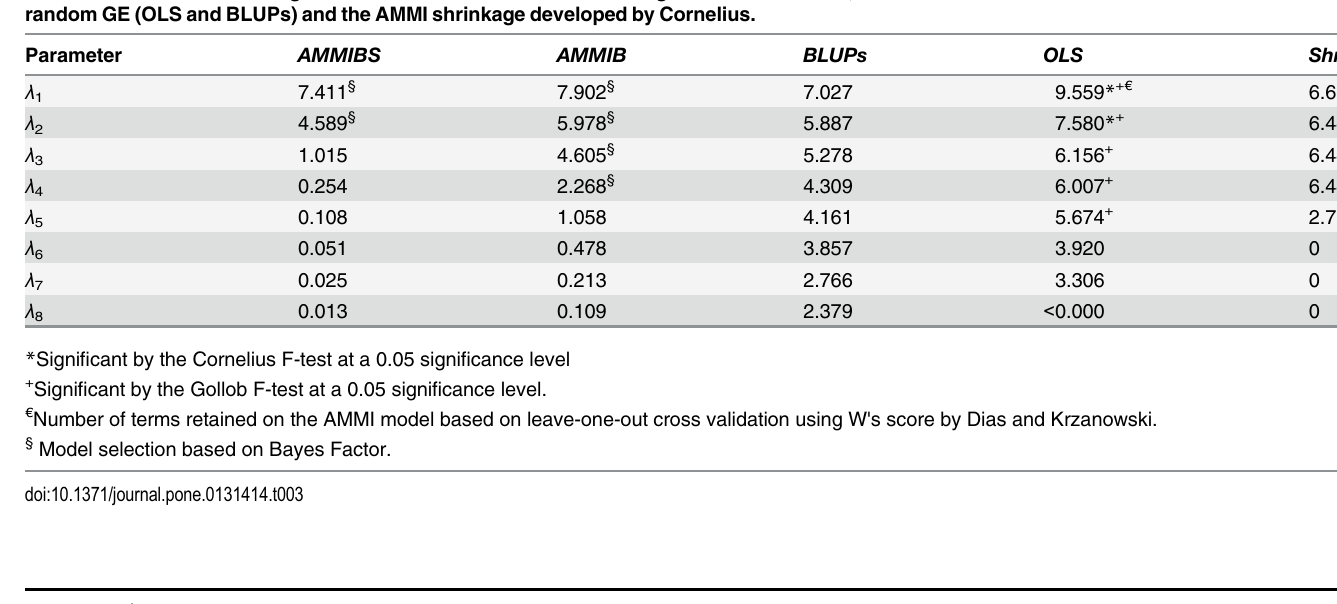
Table 3. Estimates of the singular values λ k for the AMMI model using the AMMIBS model, the AMMIB model and the AMMI model with fixed and random GE (OLS and BLUPs) and the AMMI shrinkage developed by Cornelius. Parameter AMMIBS AMMIB BLUPs OLS Shrink .